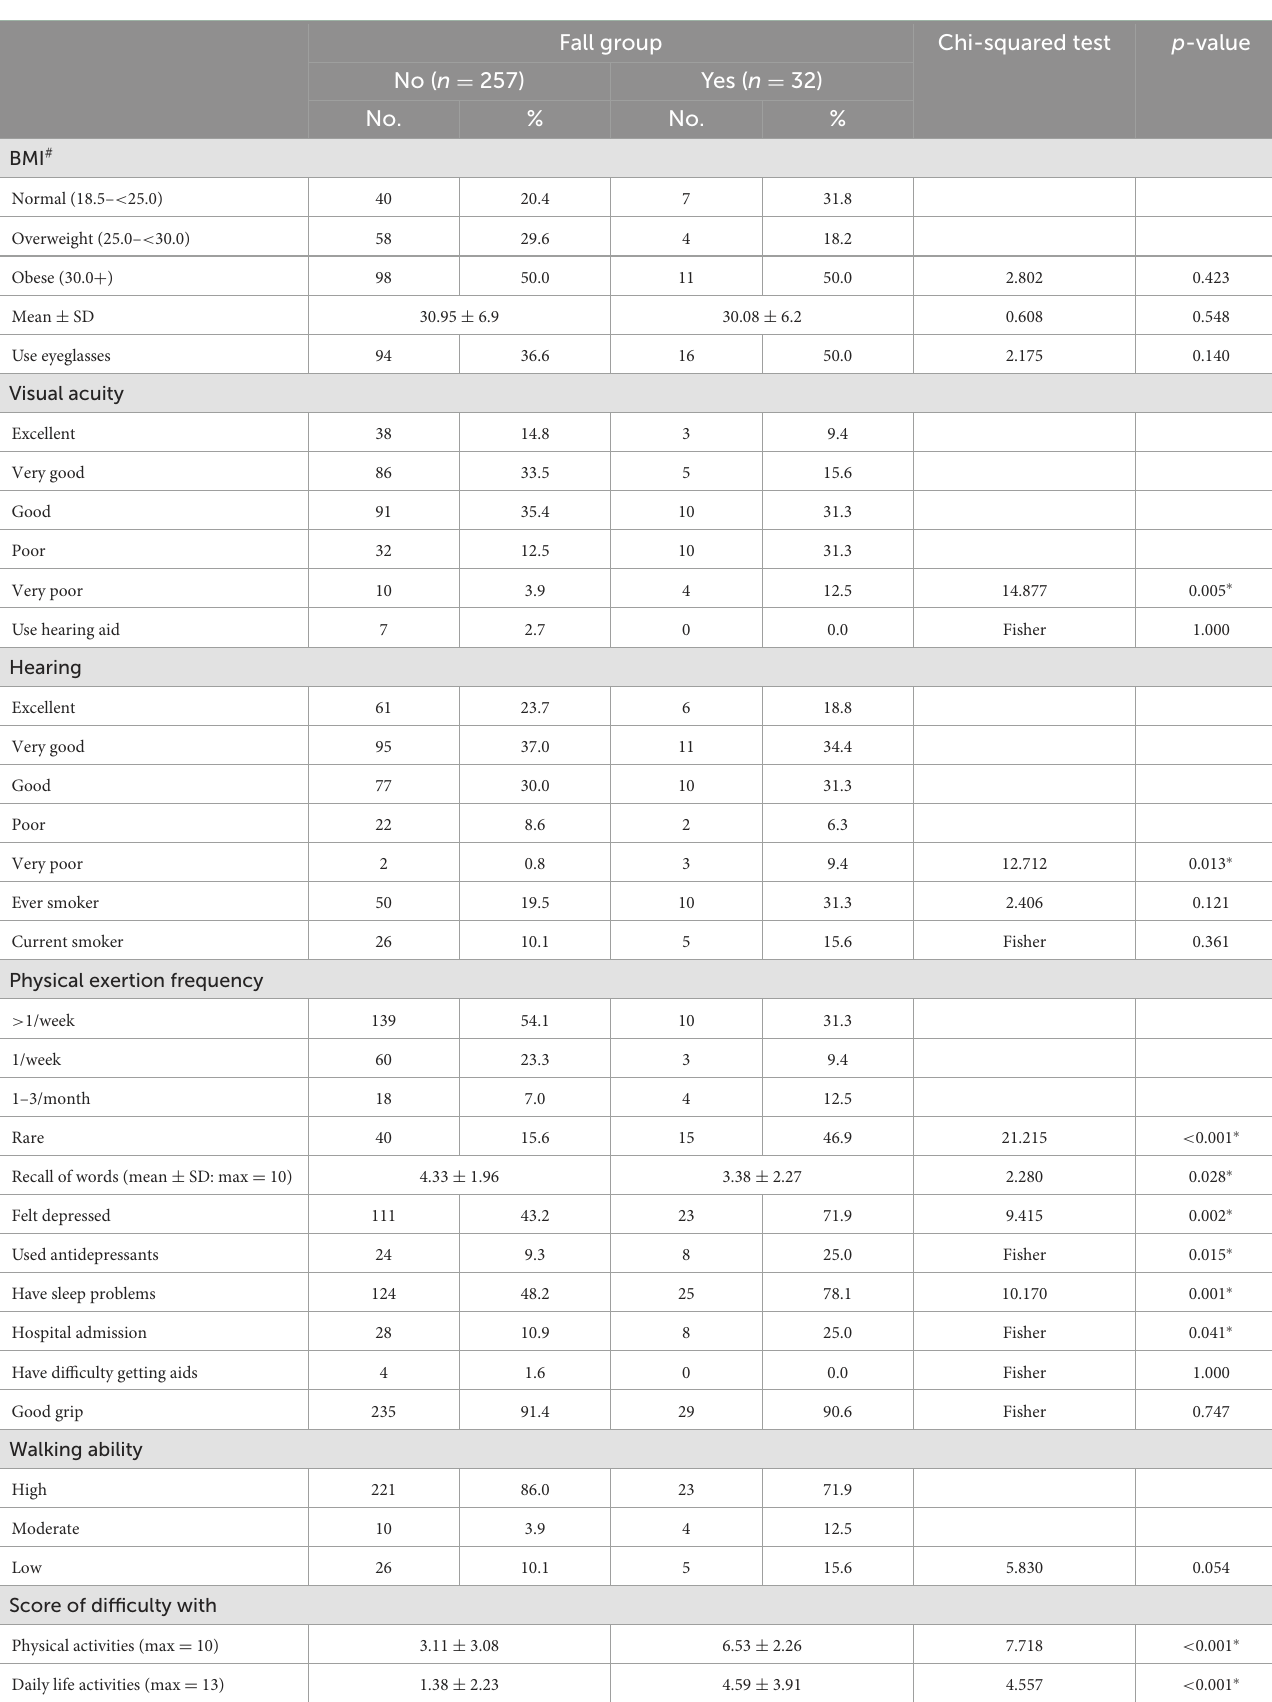
TABLE 2 Comparison of health status of old age persons with and without fall history. Fall group Chi-squared test p